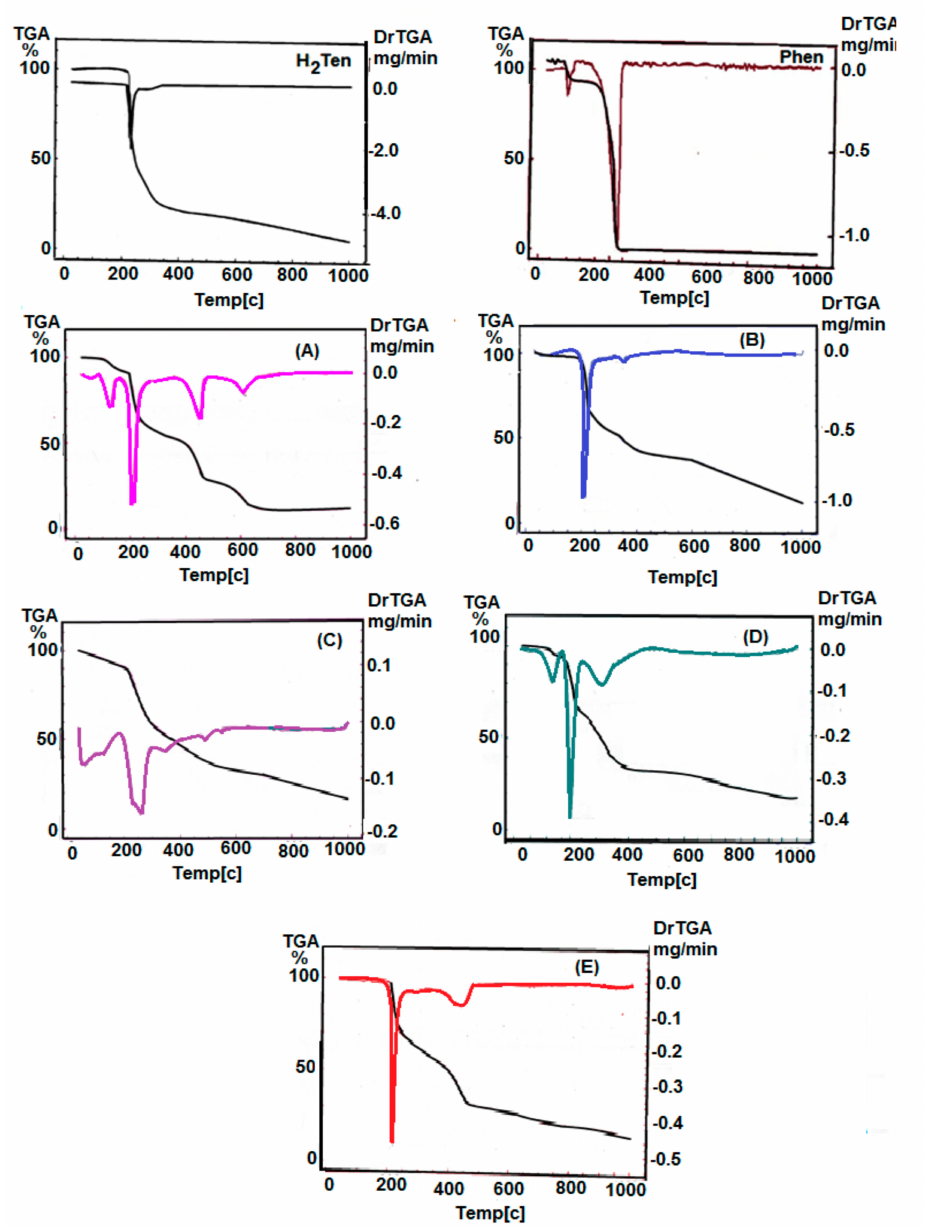
Figure 3. TGA and DTG diagram for H 2 Ten, Phen and their metal complexes. Where: H 2 Ten: Tenoxicam; Phen: 1,10-Phenanthroline; ( A ) Manganese complex; ( B ) Cobalt complex; ( C ) Nickel complex; ( D ) Cupper complex; ( E ) Zink